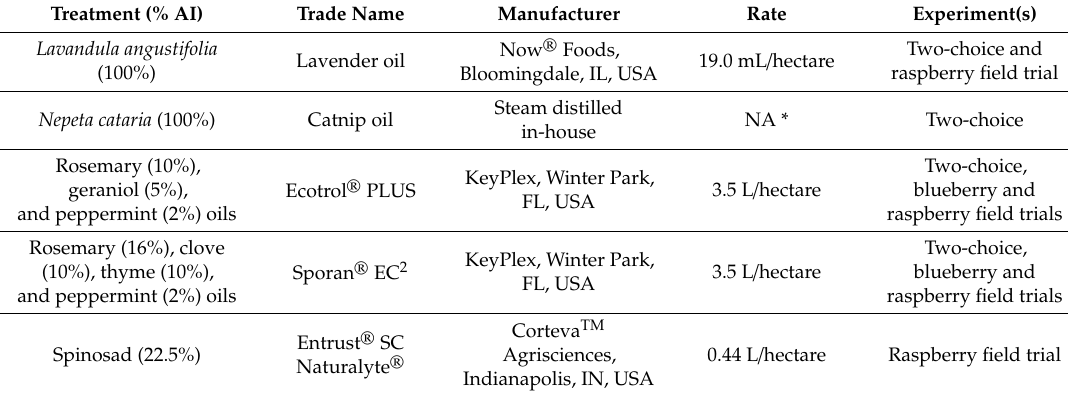
Table 1. Essential oil treatments with the percentage of active ingredients (% AI) investigated for insecticidal or deterrent e ff ects on Drosophila suzukii